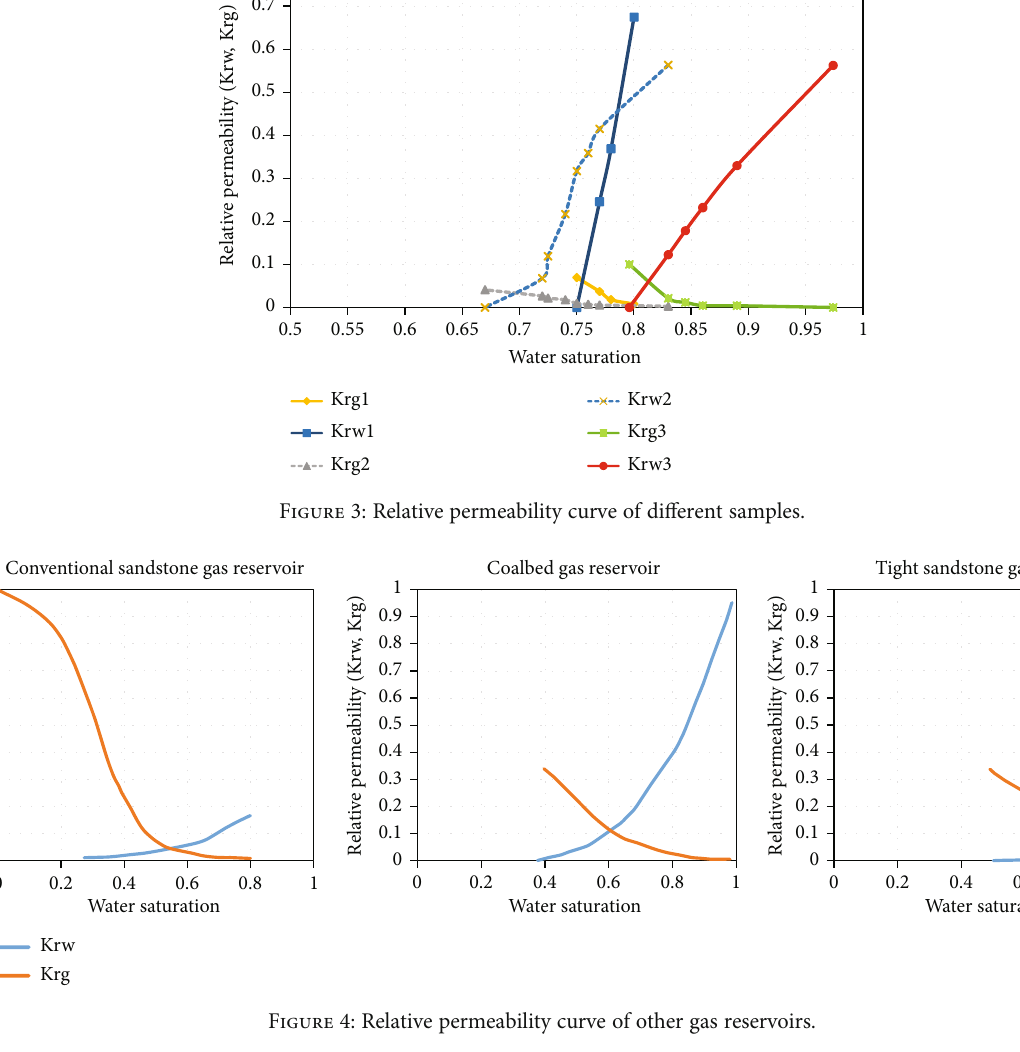
Figure 4: Relative permeability curve of other gas